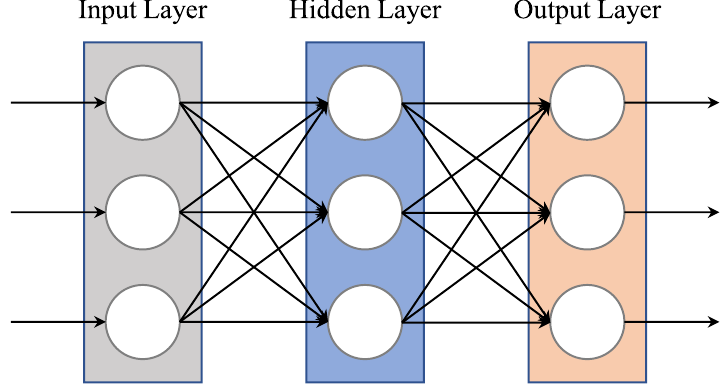
Fig. 1 Typical multi‑layer